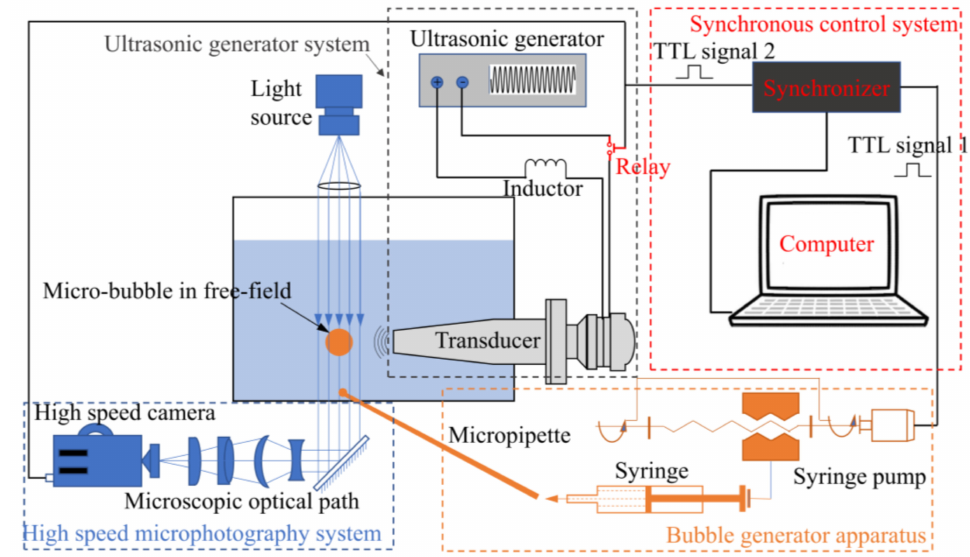
Figure 1. The schematic diagram of the experimental